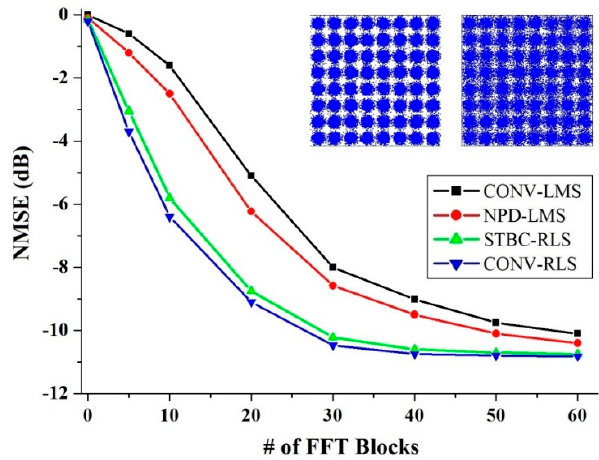
Figure 14. The NMSE vs. the number of FFT blocks for various algorithms for a PDM 16 quadrature amplitude modulation (16QAM) signal; inset: constellation diagrams before ( right ) and after ( left ) the STBC-RLS compensation [27].